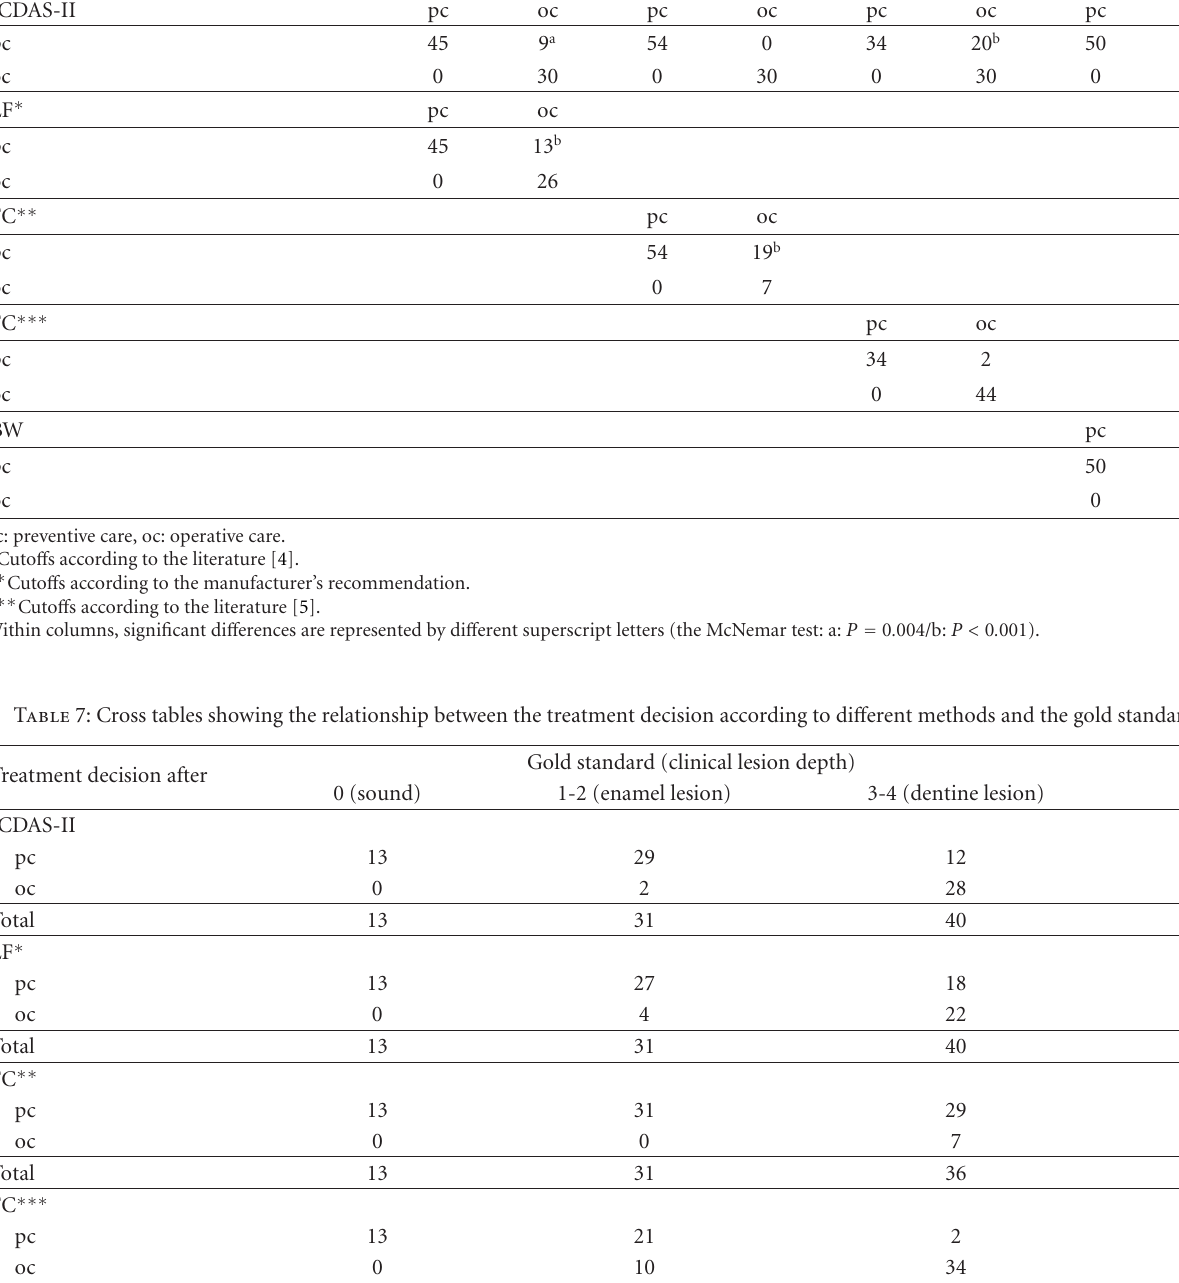
Table 6: Cross tables showing the relationship between the treatment decisions when each method was combined with the visual inspection. Treatment decision after using